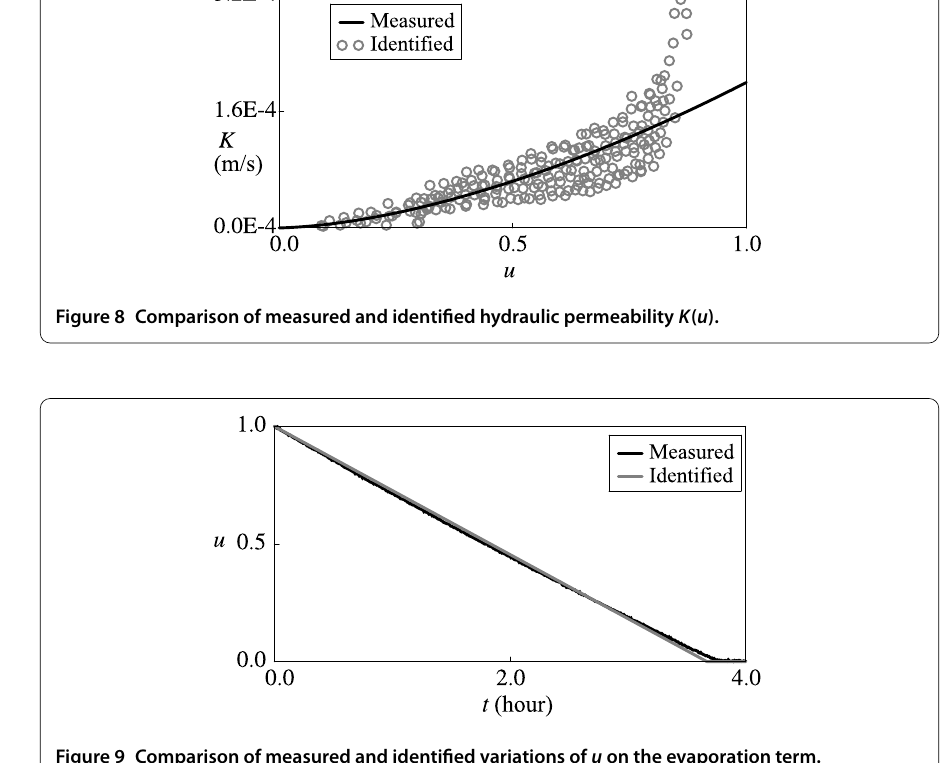
Figure 9 Comparison of measured and identified variations of u on the evaporation